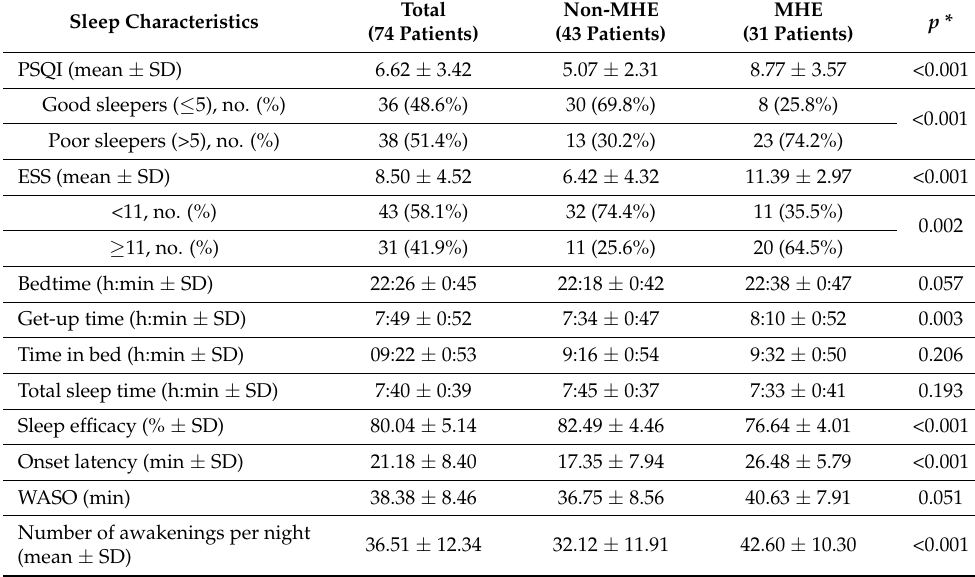
Table 5. Sleep evaluation of patients with MHE in comparison with those without